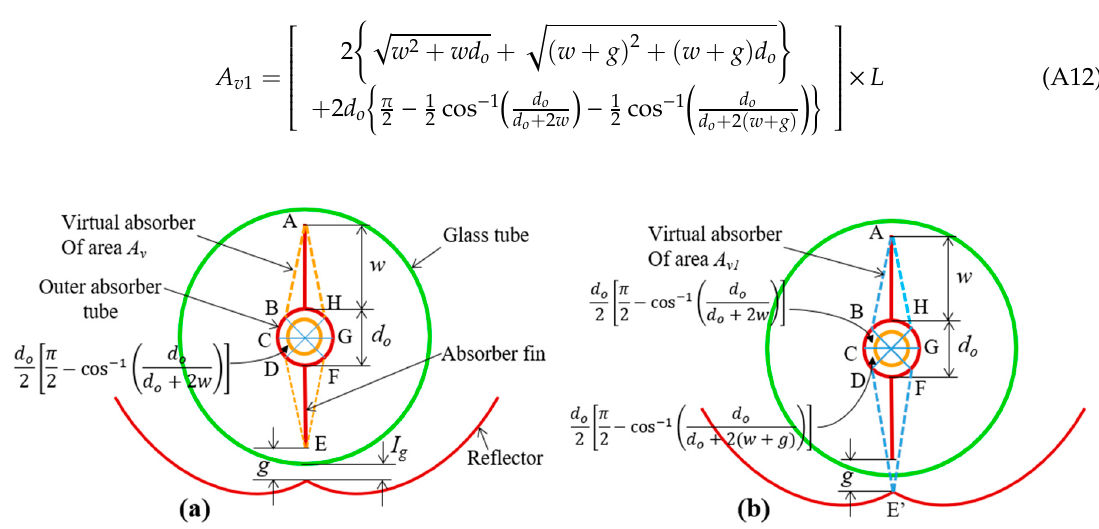
Figure A1. Virtual absorbers of concentric tube receiver: ( a ) virtual absorber enclosing the CT absorber with flat fins only; ( b ) virtual receiver enclosing CT absorber with flat fins and gap between fin and reflector cusp.